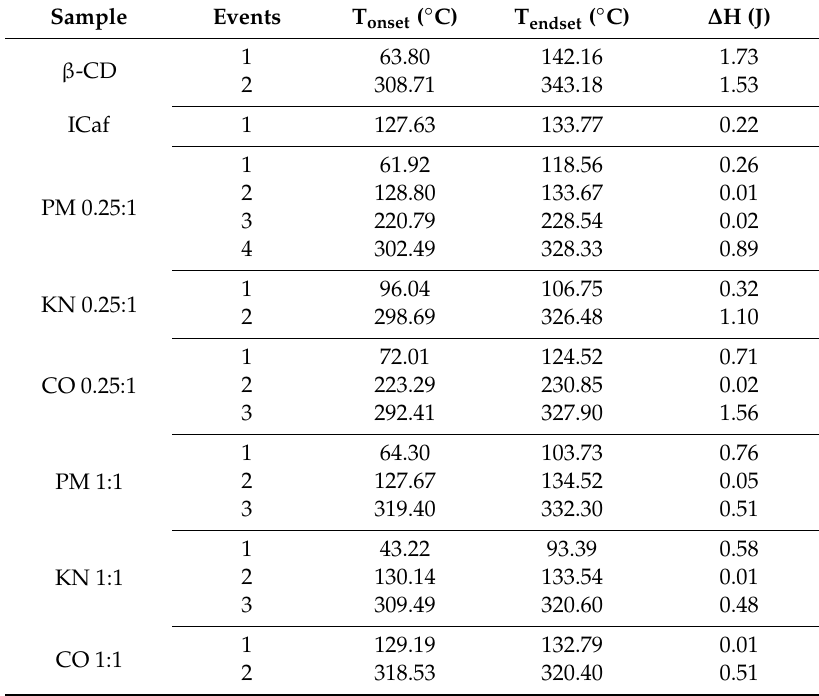
Table 1. Thermal properties of isopentyl ca ff eate (ICaf), β -cyclodextrin ( β -CD), and inclusion complex (ICaf: β -CD) prepared by physical mixture (PM), kneading (KN), co-evaporation (CO) using